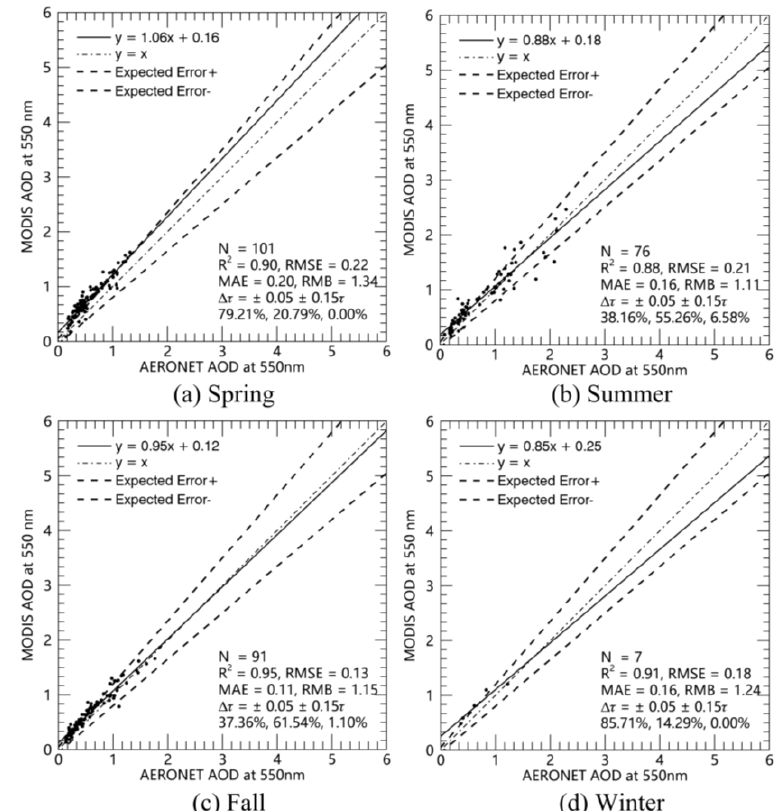
Figure 3. As for Figure 2, but showing seasonal comparisons